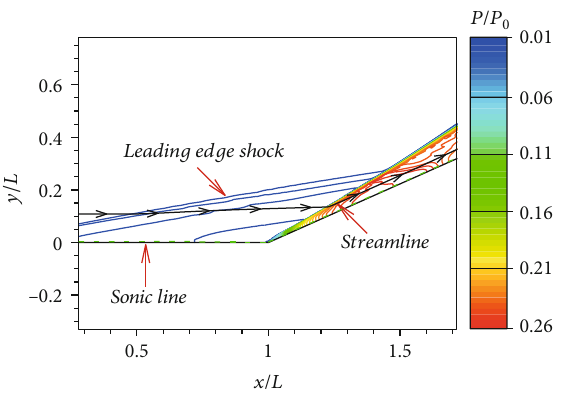
Figure 10: Flow fi eld structure induced by a ramp with MHD control